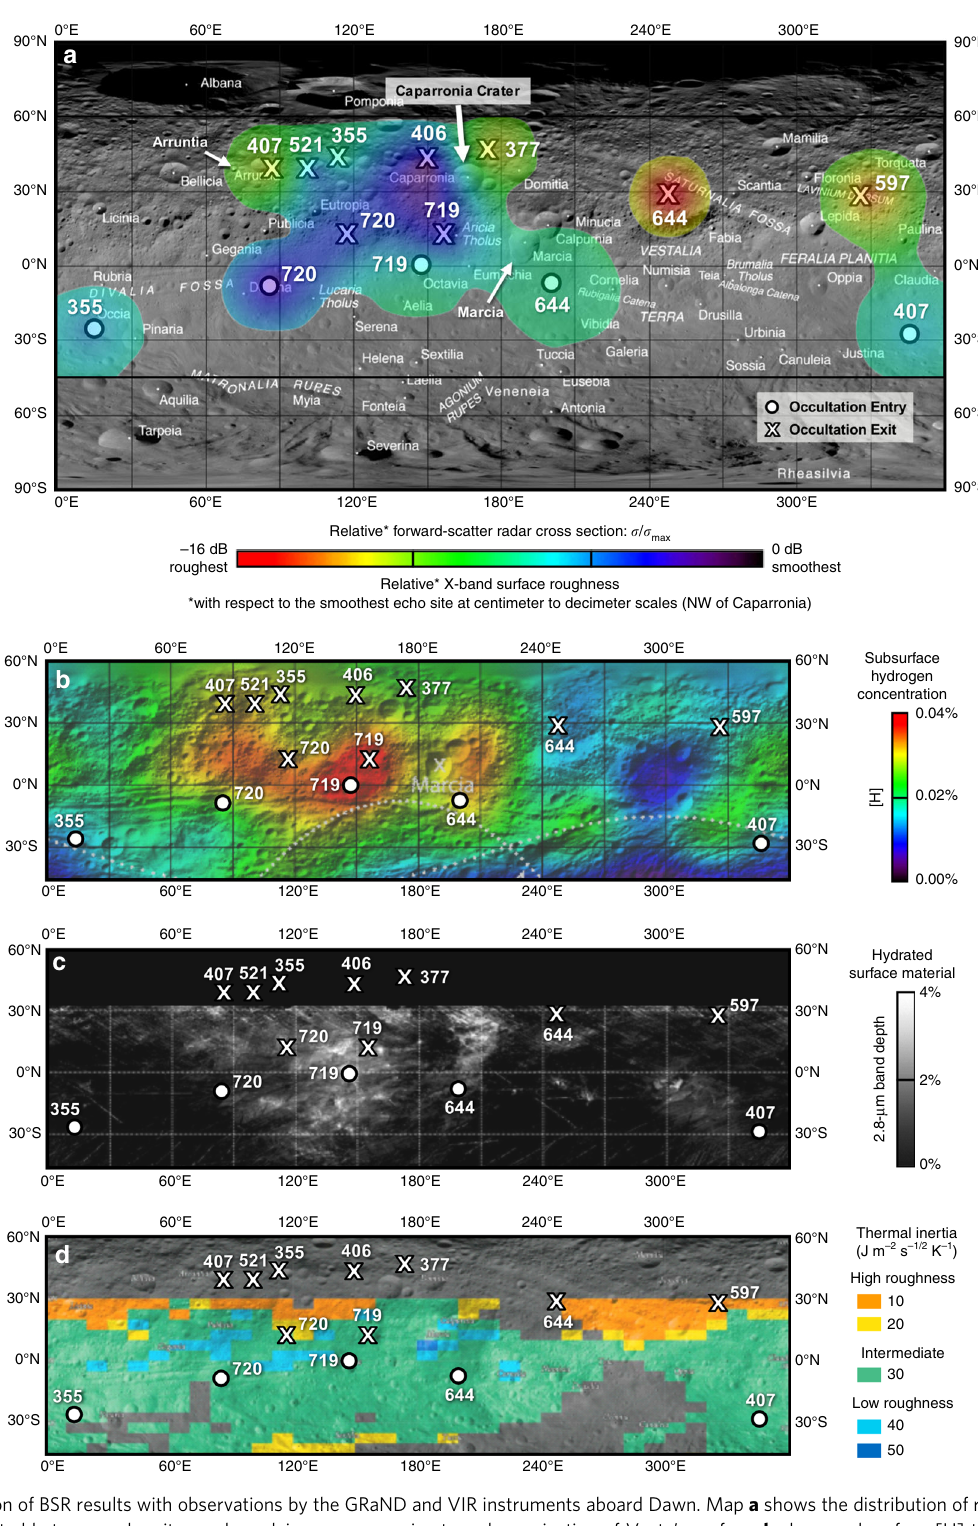
Fig. 3 Comparison of BSR results with observations by the GRaND and VIR instruments aboard Dawn. Map a shows the distribution of relative radar cross section interpolated between echo sites and overlain upon an equirectangular projection of Vesta ’ s surface; b shows subsurface [H] to a depth of a few decimeters 17 ; c shows the distribution of hydrated material at the surface 18 ; and d shows the surface ’ s thermal inertia and multi-meter-scale topography modeled from VIR thermal observations 19 . O ’ s and X ’ s mark locations where BSR surface echoes have been detected during the associated orbit